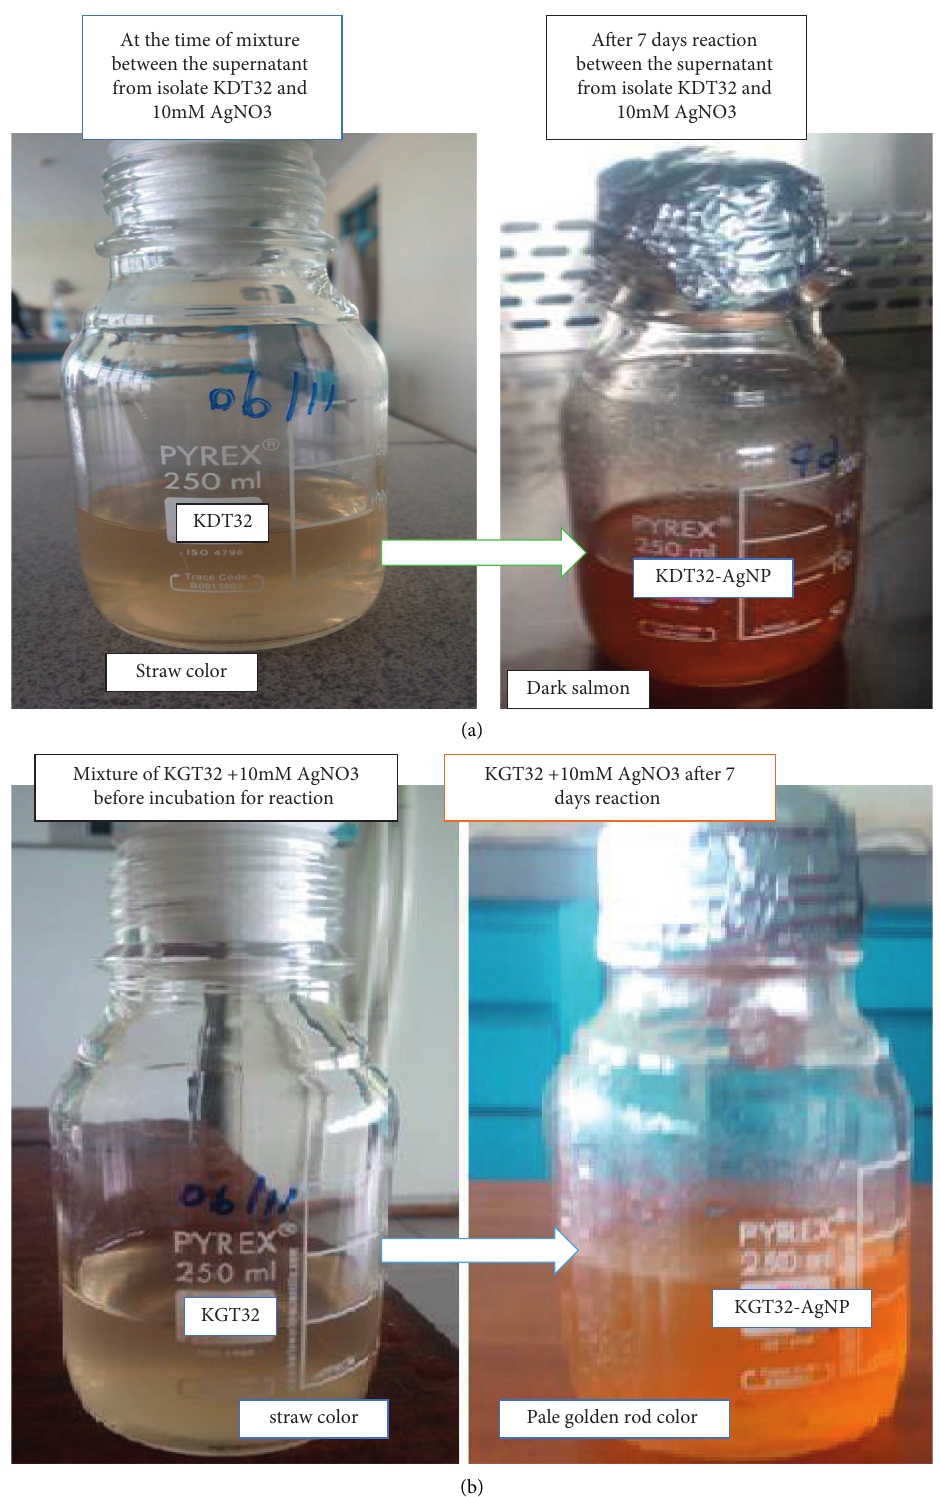
Figure 1: Color changes after KDT32-AgNPs (a) and KGT32-AgNPs (b)